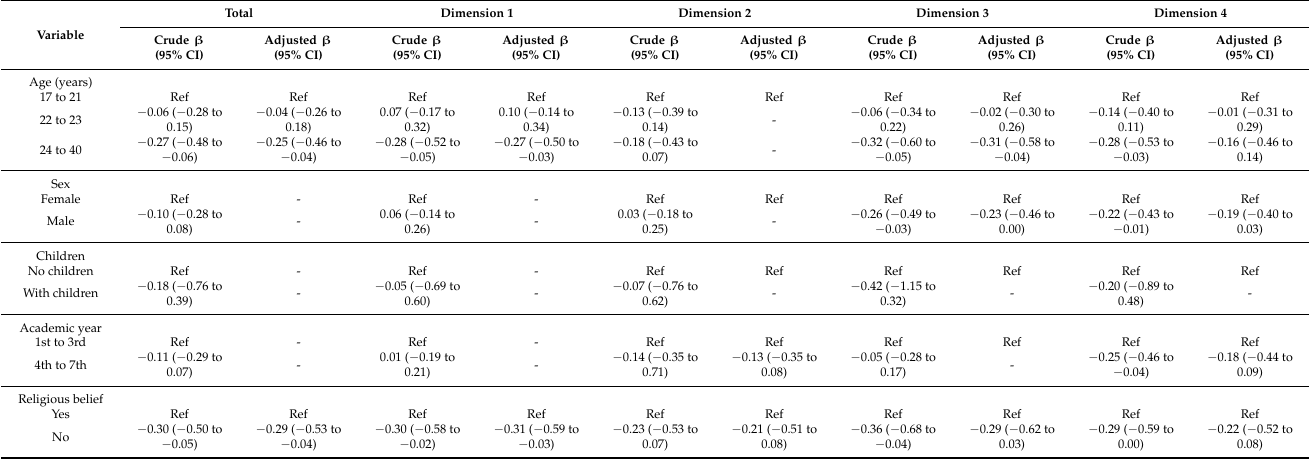
Table 3. Factors associated with the Collet–Lester fear-of-death scale score in the study